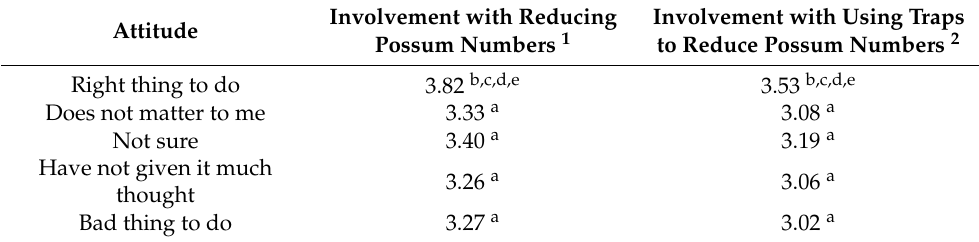
Table 4. Involvement and attitude towards trapping